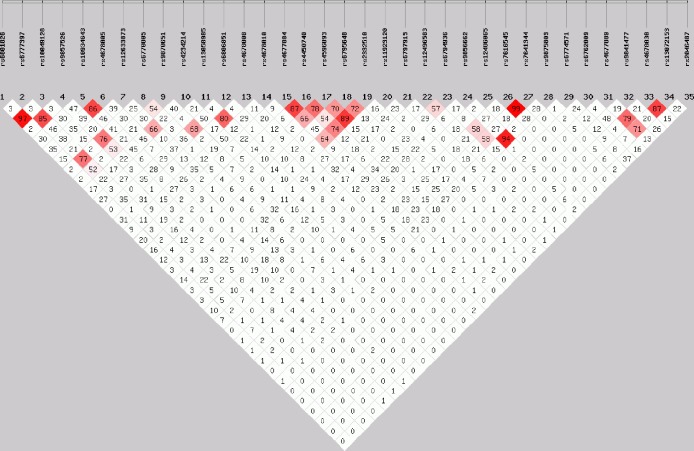
Pairwise linkage disequilibrium between SNPs, as measured by r2, in the ADCY5 gene.Numbers within diamonds indicate the r2 value between the two SNPs defined by the upper left and the upper right sides of the diamond. For example, r2 between rs6801826 (SNP 1) and rs6777397 (SNP 2) is 0.03. The plot was generated by the SHEsis Online Version. Key: r2 = 0 is given in white, and 0 < r2 ≤ 1 is given in shades of red (redder color represents higher r2).